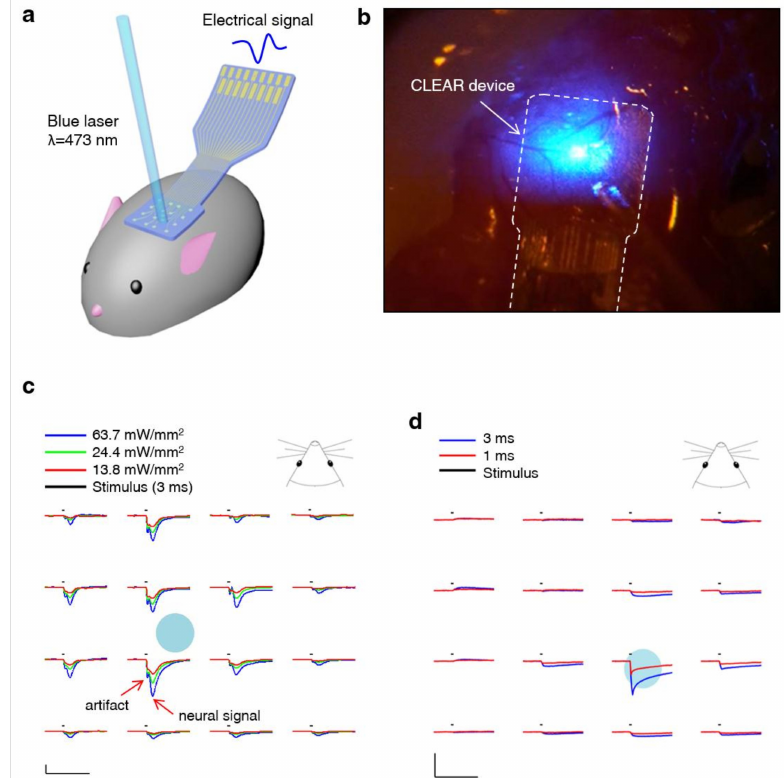
Figure 5. ( a ) Illustration depicting experimental ensemble combining optical stimulation with µ ECoG in a mouse model. ( b ) Optical illumination and stimulation spatially control over the mouse brain and µ ECoG via an optical fiber. ( c ) Spatial mapping of local field potentials obtained from a graphene µ ECoG throughout an optically evoked potential on the cortex of a channel rhodopsin positive mouse; x -scale bars represent 50ms, y -scale bars represent 100 µ V. ( d ) Post-mortem control depicting photo-electric artefact generated during blue-light optical stimulation; x -scale bar, 50ms; y -scale bars, 100 µ V. Reprinted with permission from Reference [44].